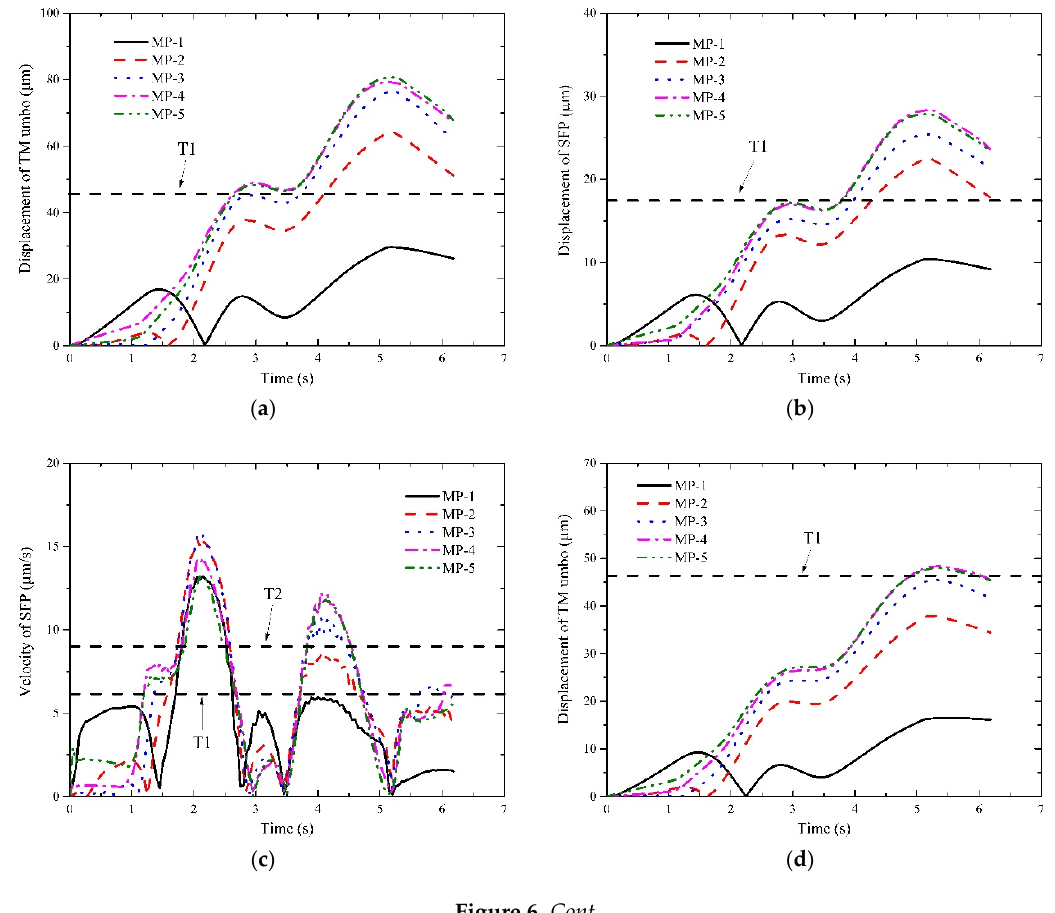
Table 4. The pressure differences in different cabins (Unit: